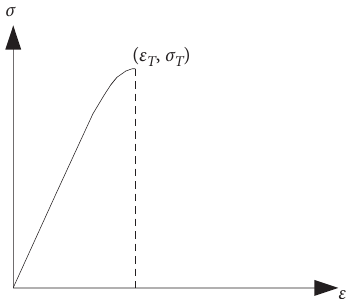
Figure 1: Simplified mechanical properties of concrete under uniaxial